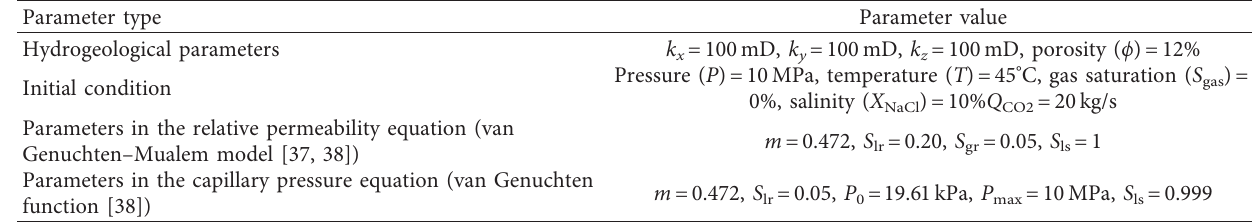
Table 1: The parameters of the model in the simulation.